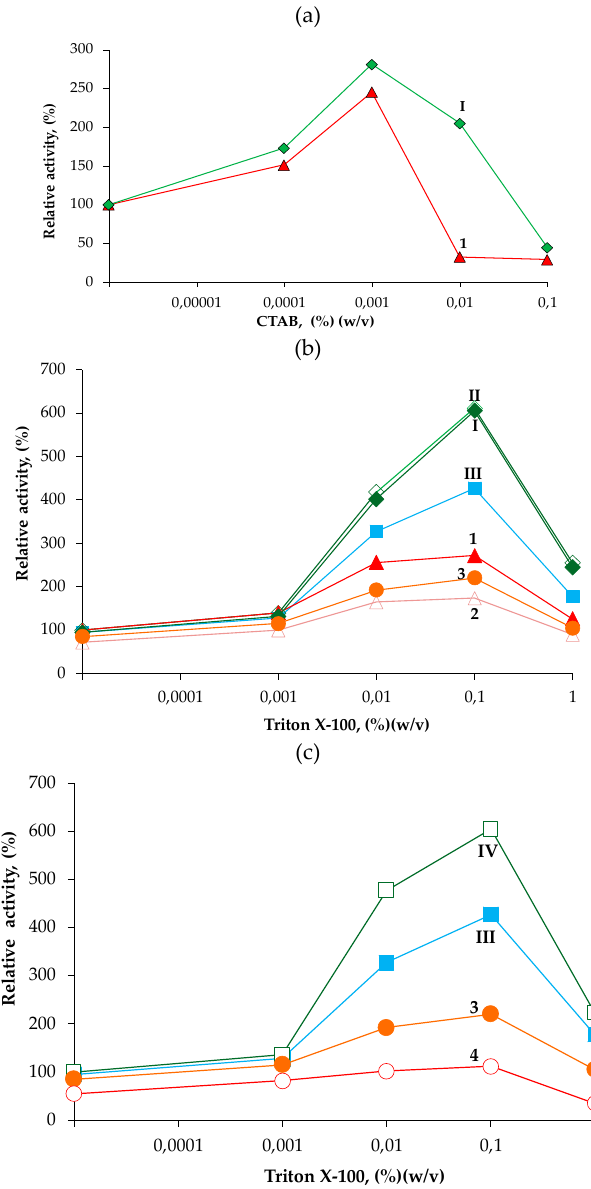
Figure 3. Effect of hexadecyltrimethylammonium bromide (CTAB) ( a ) on the hydrolytic activity of unmodified CNBr derivatives of BTL2 (“1” or red triangles) and cc BTL2 (“I” or green rhombus ). Effect of sequential pretreatments on hydrolytic activity of CNBr lipase derivatives in the presence of Triton X-100. ( b ): (“I” or green rhombus) cc BTL2 and (“1” or red triangles) BTL2 as obtained; (“II” or open green rhombus) cc BTL2 and (“2” or open pink triangles) BTL2 after incubation with 200 µM Cu 2+ (first treatment). (b) and ( c ): (“III” or solid cyan squares) cc BTL2 and (“3” or solid orange circles) BTL2 after posterior incubation with 25 mM DTT (second treatment). (c): (“IV” or open green squares) cc BTL2 and (“4” or open red circles) BTL2 re-incubated with 200 µM Cu 2+ (third treatment). Values are relative to the respective unmodified derivative activity (5 IU p -nitrophenyl butyrate ( p -NPB) and 0.013 mg of protein/g) in the absence of detergents for cc BTL2.